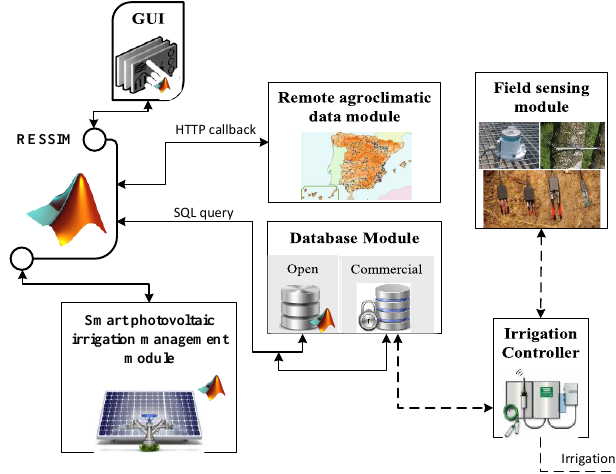
Figure 1. Architecture of Real time Smart Solar Irrigation Manager (RESSIM).